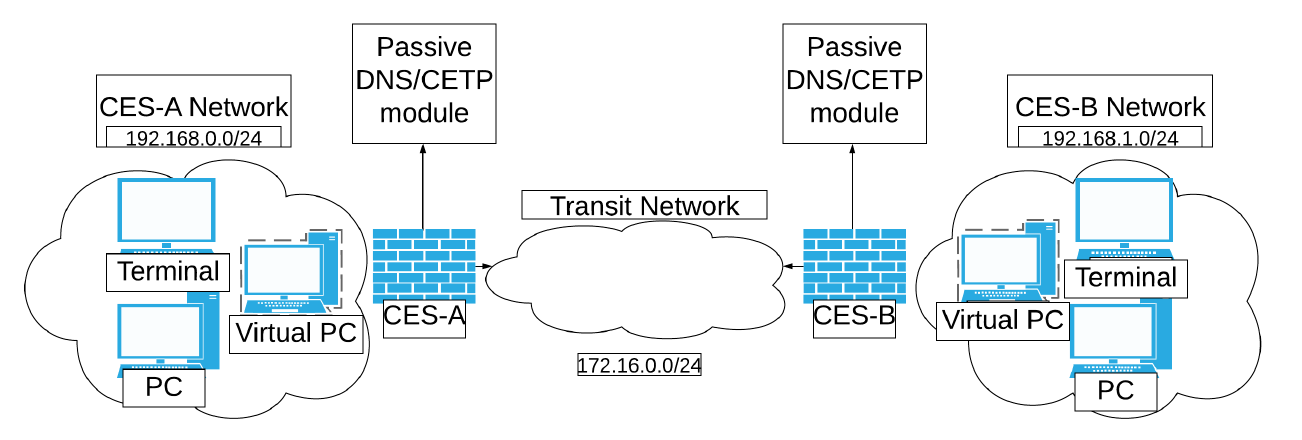
Figure 12. Implementation of the CES-to-CES